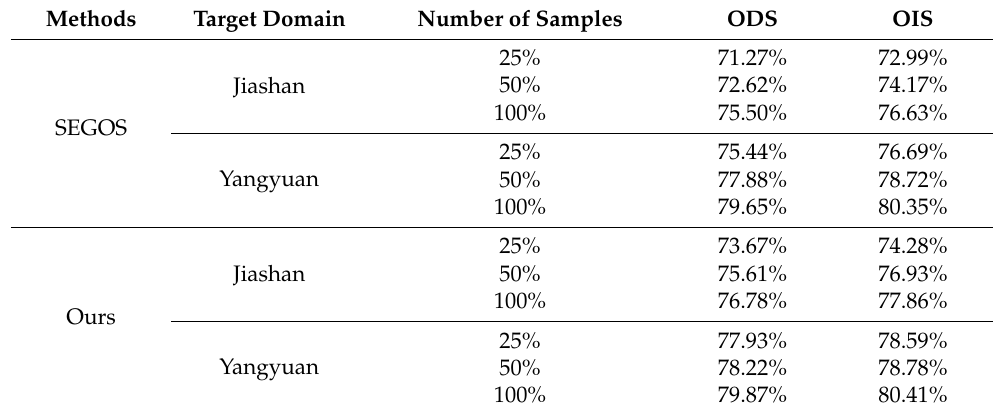
Table 4. Accuracy comparison of SEGOS and our method using different numbers of target do- main samples.